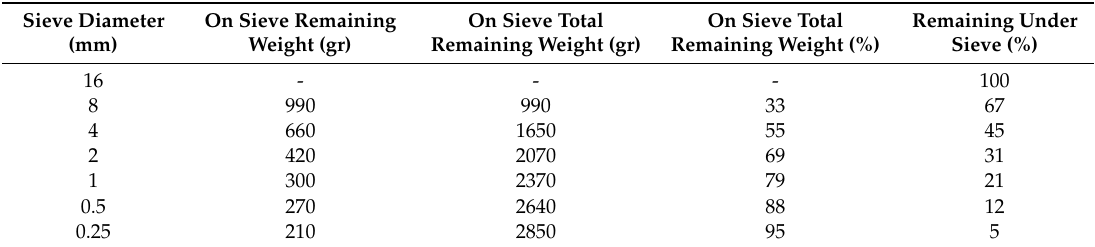
Table 36. The average compressive and bending strength test results of concrete types.